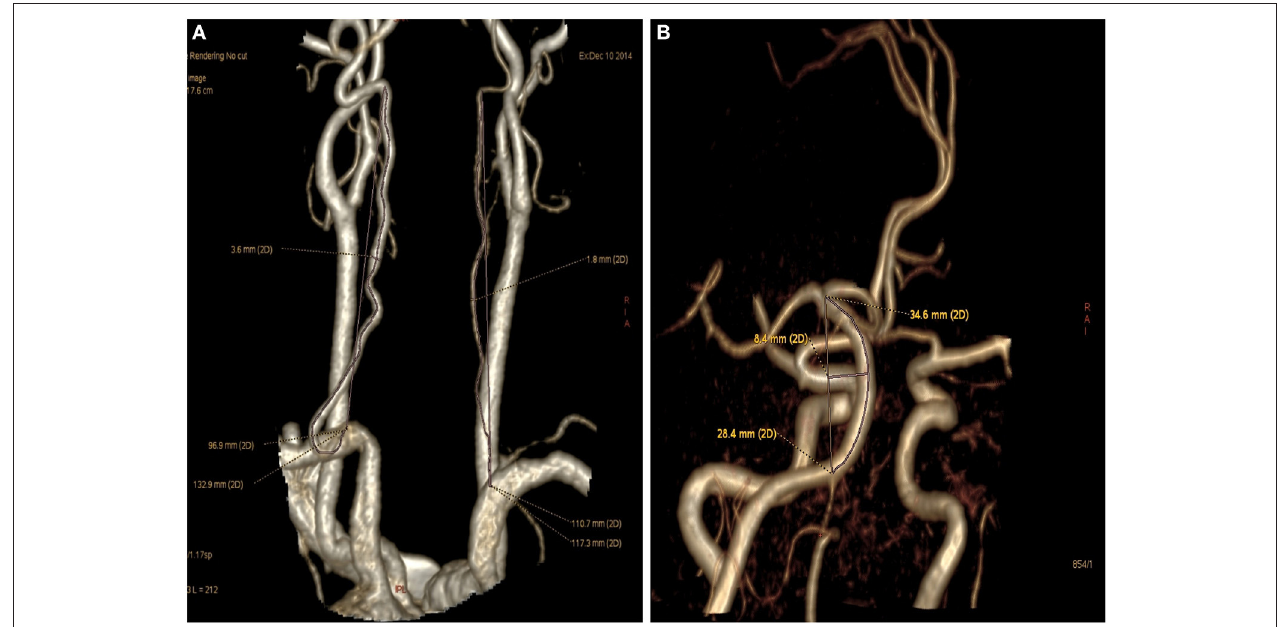
FIGURE 1 | Vertebral artery and basilar artery curvature measured. (A) Left vertebral artery (V1-V2) actual length was 132.9mm and straight length was 96.9mm (Curvature index of VA = 132.9 – 96.9/96.9 × 100% = 37.2%), right hypoplastic vertebral artery actual length was 117.3mm and straight length was 110.7mm. (B) Basilar artery actual length was 34.6mm, basilar artery straight length was 28.4mm, basilar bending length was 8.4mm.